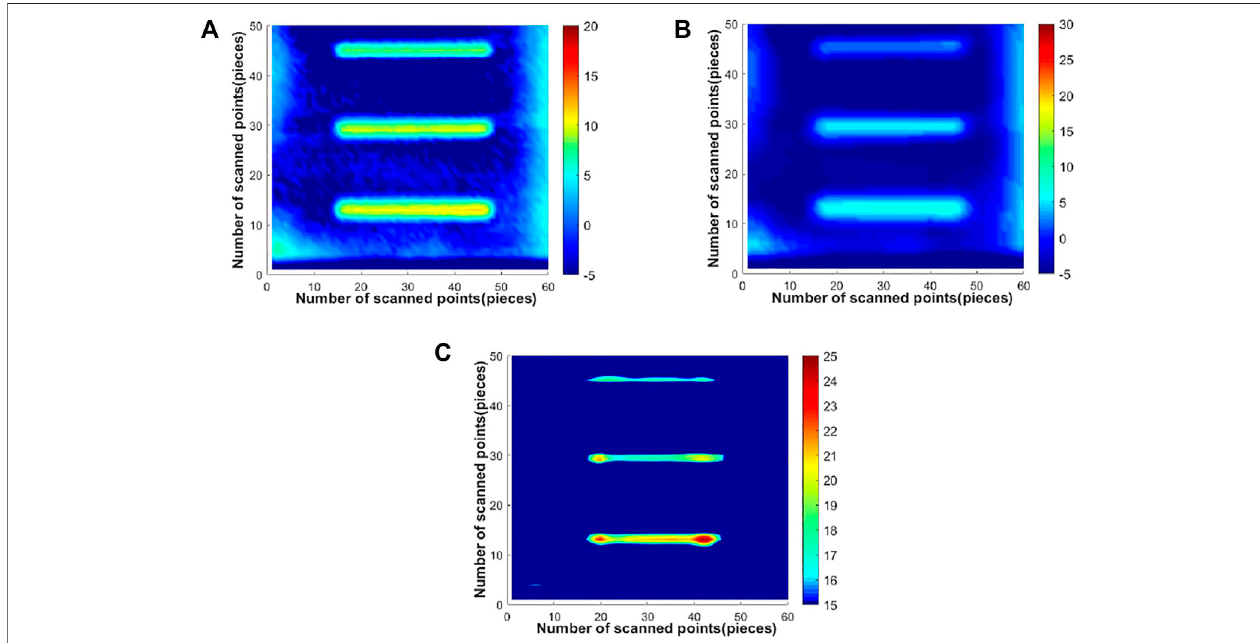
FIGURE 8 | Image of processing results of each method for delamination defects in sample 2. (A) image of original detection, (B) Gaussian fi ltering, (C) method in this paper.